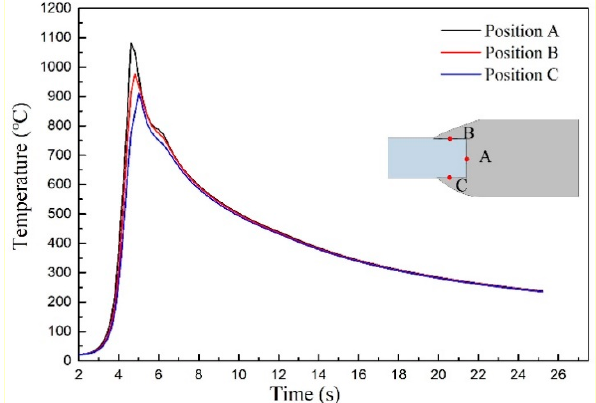
Figure 8. Temperature profiles of different positions at Al/Steel interface.